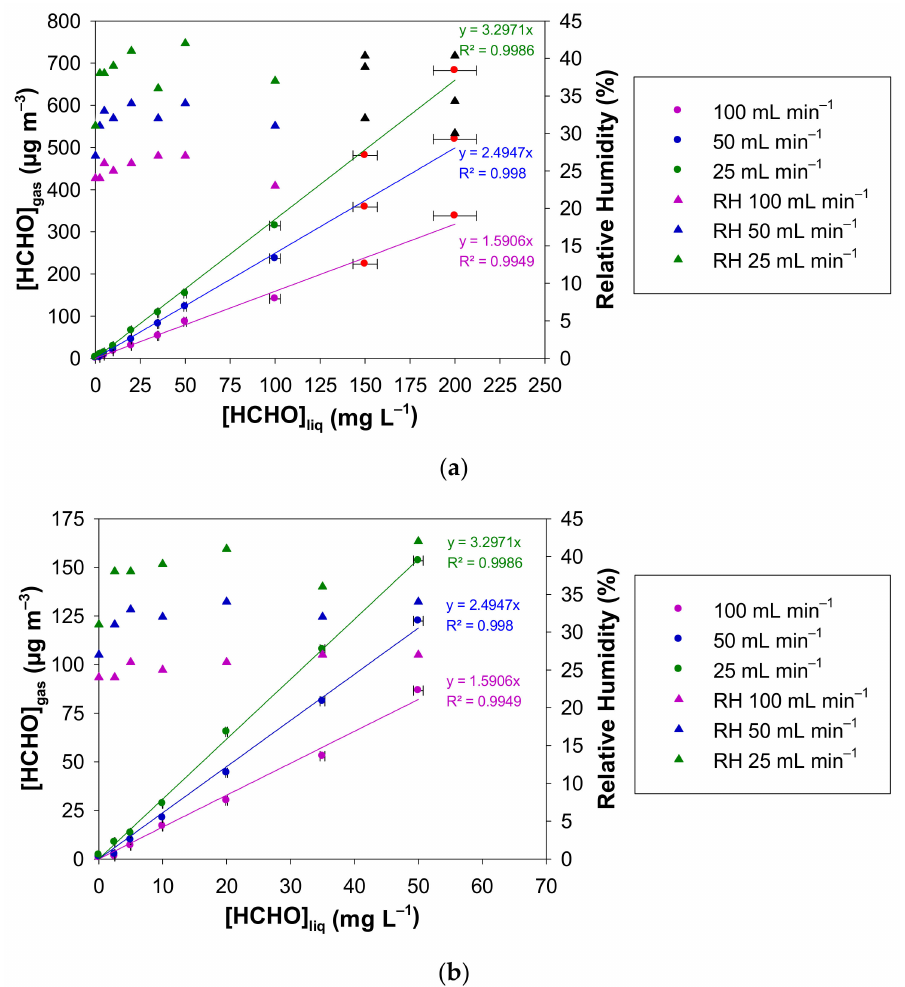
Figure 5. Concentration of the generated gaseous formaldehyde and relative humidity measured with the formaldehyde analyser ( µ F1, Chromatotec, Val-de-Virv é e, France) vs. the liquid formaldehyde concentration for three different gas flow rates (25 mL min − 1 in green, 50 mL min − 1 in blue and 100 mL min − 1 in purple). The other parameters were fixed as follows: T = 10.7 ◦ C, L = 7 cm, photomul- tiplier gain = 50%. The liquid formaldehyde concentrations were in the ranges: ( a ) 0–200 mg L − 1 and ( b ) 0–50 mg L − 1 . The horizontal error bars correspond to the uncertainties calculated from the preparation of the liquid formaldehyde solution. The vertical error bars correspond to two times the standard deviation, but they are too small to be visible. Red circles and black triangles mean that the generated gaseous formaldehyde mixture has been diluted prior to analysis, so a correction has been applied to obtain the real values of [HCHO] gas and